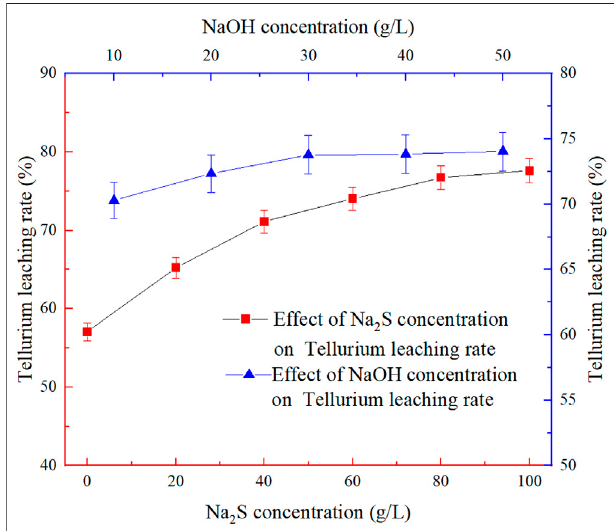
FIGURE 4 | Effect of leaching agent dosage on tellurium leaching rate.